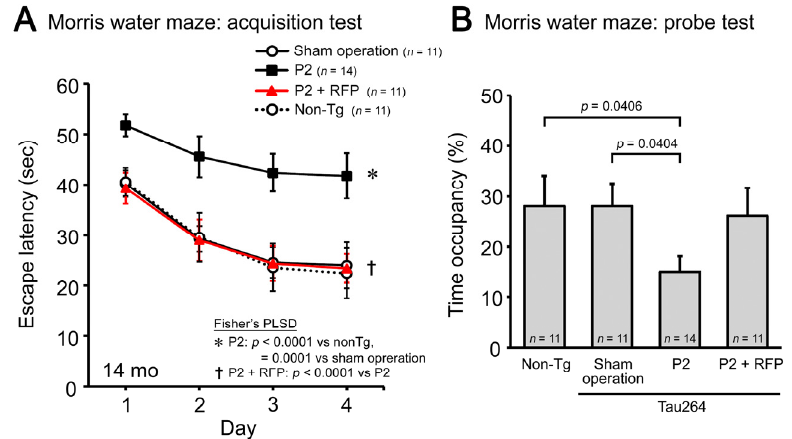
Figure 5. Cognitive decline and the effects of rifampicin treatment. The cognitive function of mice was evaluated by the Morris water maze. ( A ) P2-injected, CMC-treated mice, but not sham-operated mice, showed a significant impairment in the acquisition of spatial reference memory. This cognitive decline was prevented by rifampicin treatment. ( B ) In the probe trials, P2-injected, CMC-treated mice showed disturbed memory retention. Rifampicin-treated mice possessed normal